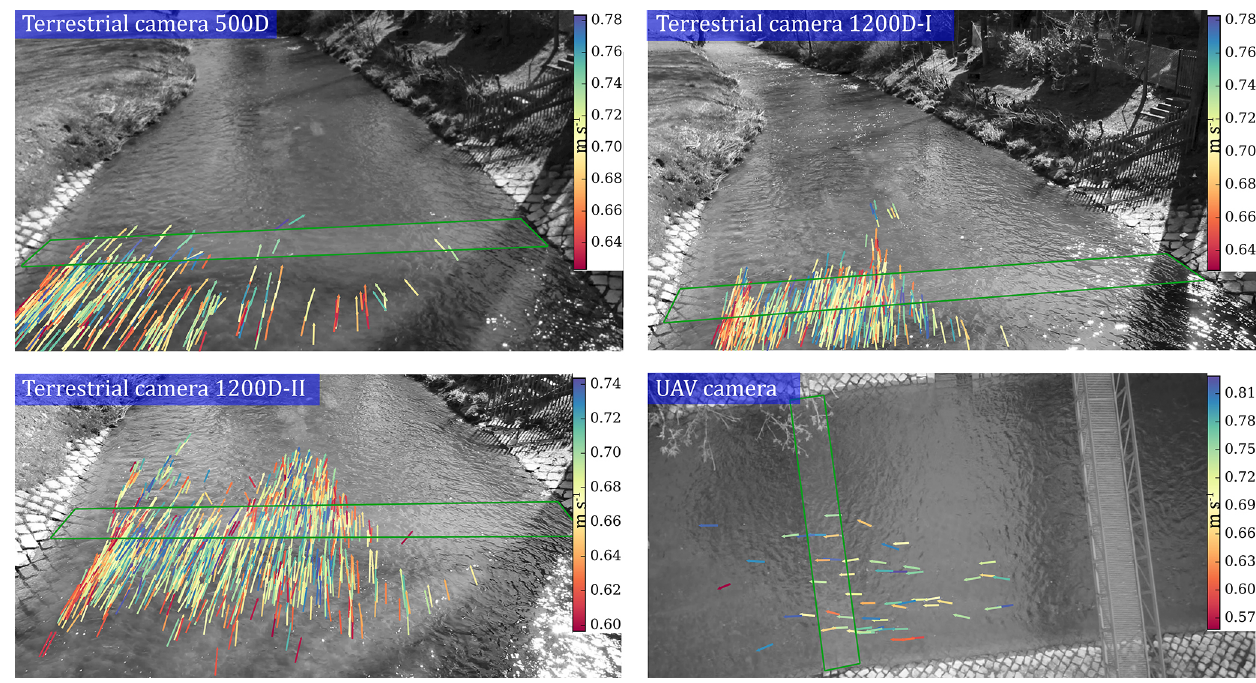
Figure 7. Flow velocities estimated at the Wesenitz using video frames captured with three different terrestrial cameras and a camera on a UAV platform. Final tracks after the statistical outlier filter (Fig. 5f) are displayed. Green border indicates area, in which image-based measurements are compared to ADCP velocities. Table 3. Deviation between ADCP measurements and video-based flow velocities. Differences are calculated for tracks within a range of 1 m and are closest to the ADCP